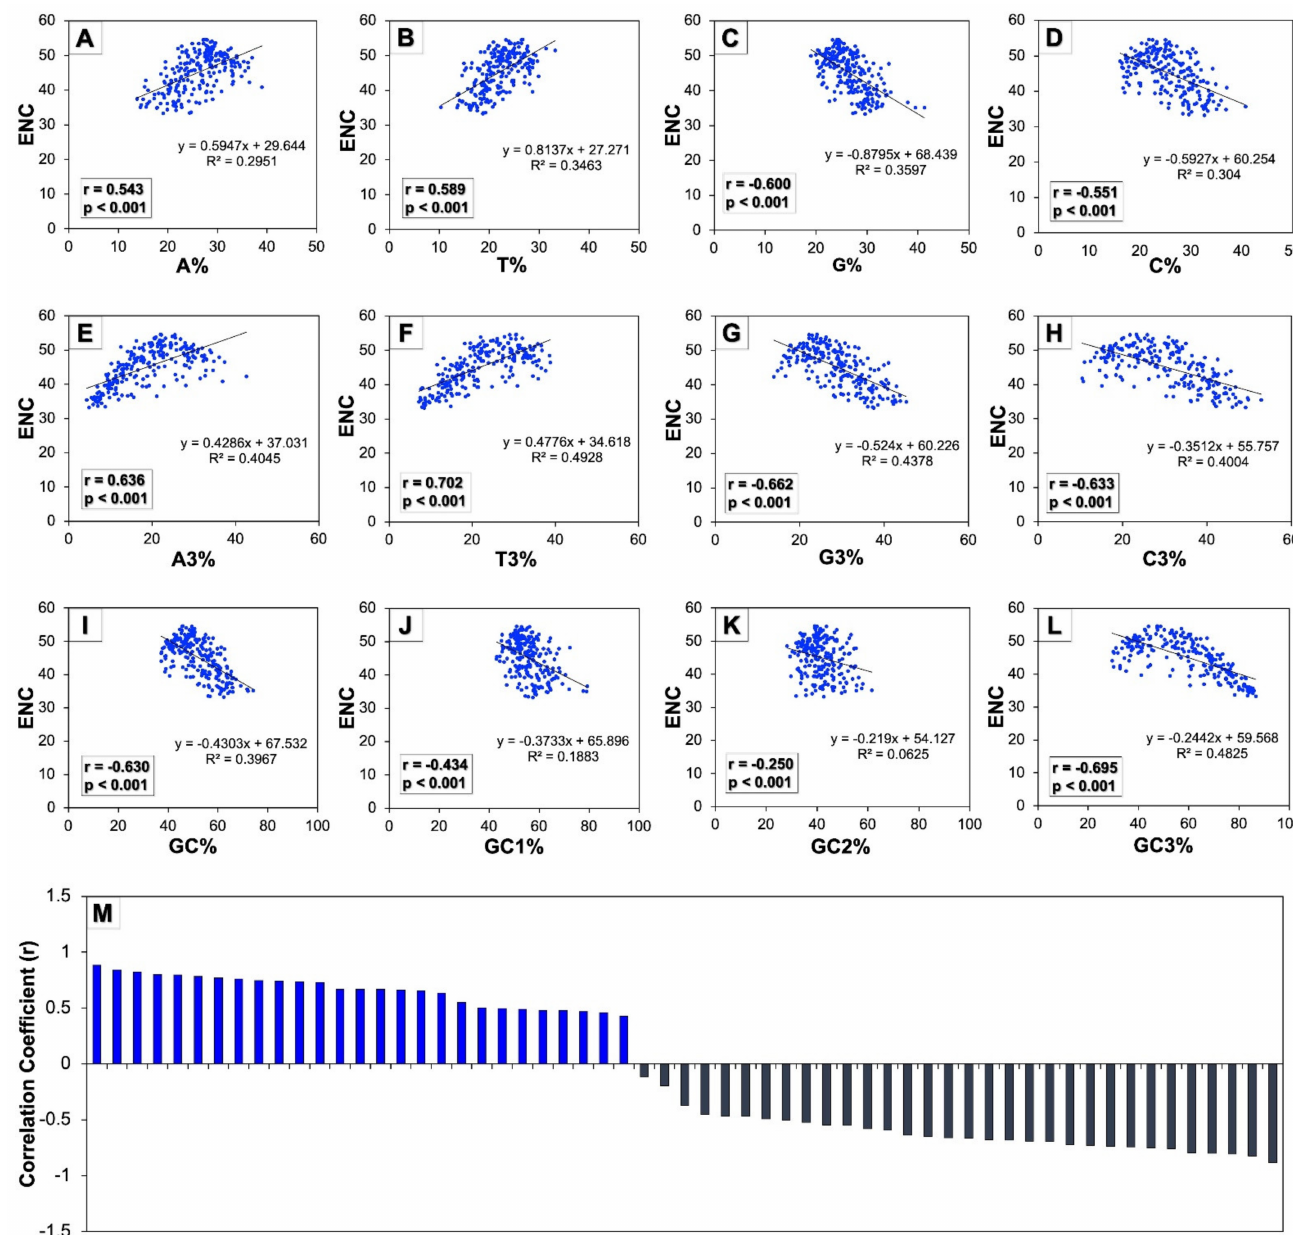
Figure 3. Regression analysis among ENC and various nucleotide composition of human autophagy genes. Scattered regression plots between ENC and individual nucleotide composition ( A – D ), between ENC and nucleotides at third codon position ( E – H ), and between ENC and GC contents ( I – L ) were analyzed. The insets in all the regression plots represent their corresponding correlation coefficients and p values. ( M ) represents the correlation between codon usage and GC3 across all 224 genes involved in human